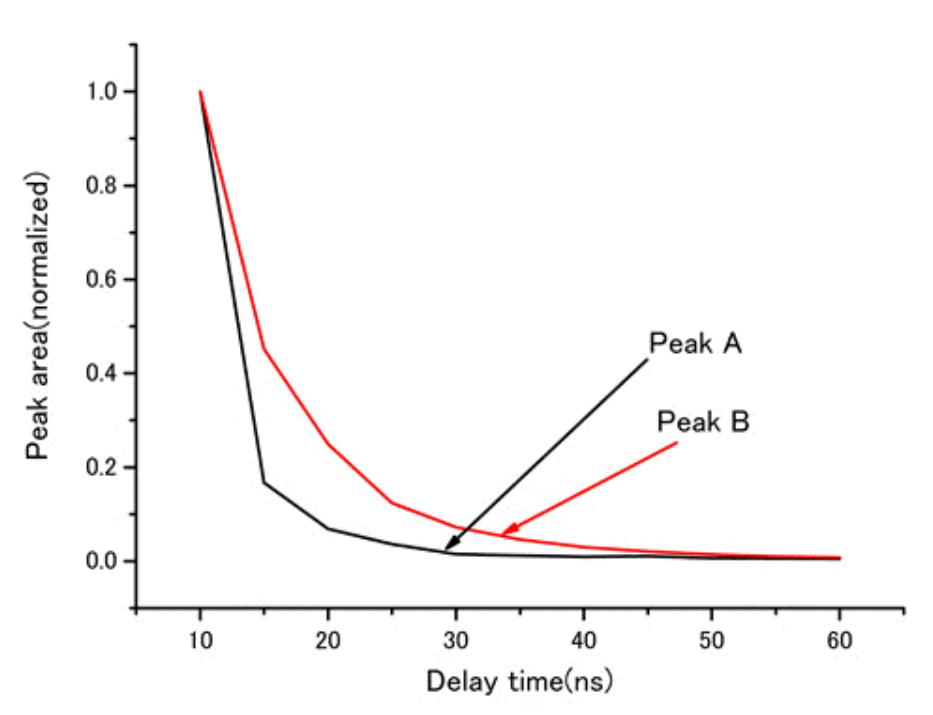
FIGURE 10 . Fluorescence intensity of peak A and peak B with respect to the delay time.